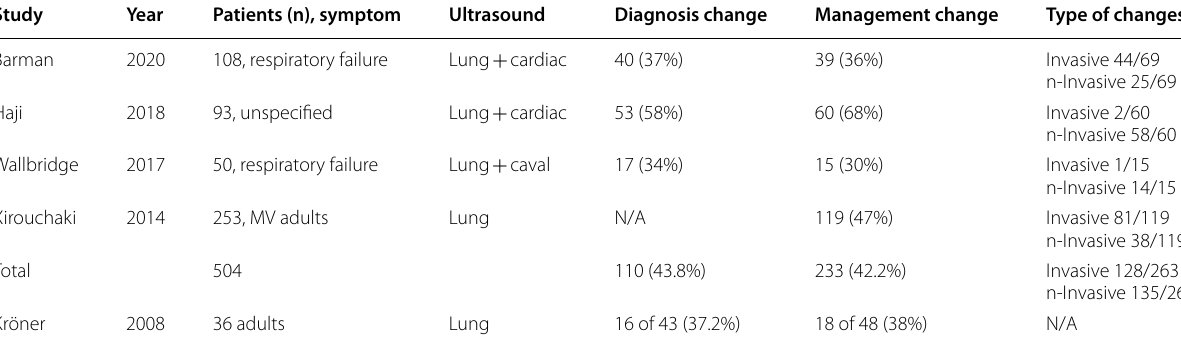
MV mechanically ventilated; N/A not available; TOTAL referred to the compilation of studies published after April 2008; ICU intensive care unit